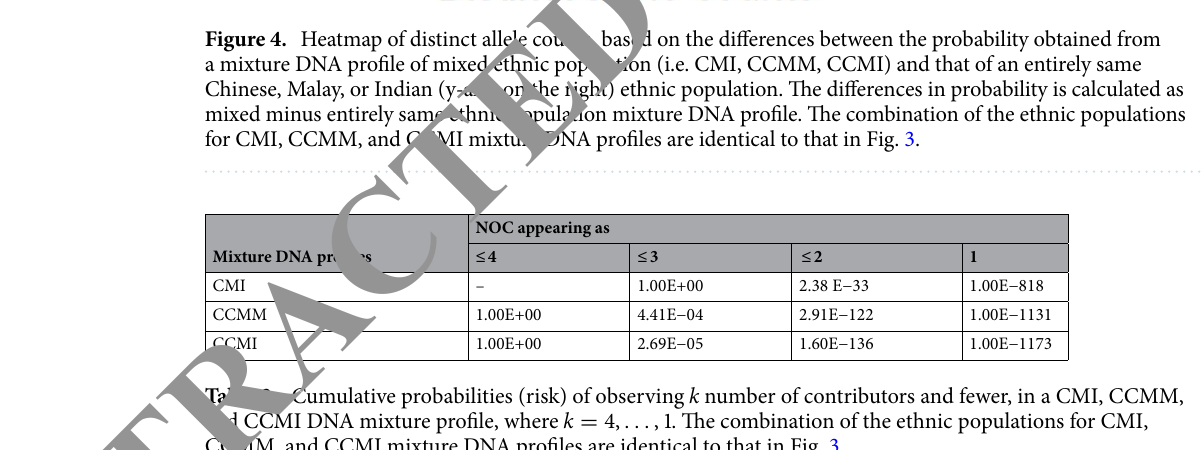
Table 2. Cumulative probabilities (risk) of observing k number of contributors and fewer, in a CMI, CCMM, and CCMI DNA mixture profile, where k = 4, . . . , 1 . The combination of the ethnic populations for CMI, CCMM, and CCMI mixture DNA profiles are identical to that in Fig. 3